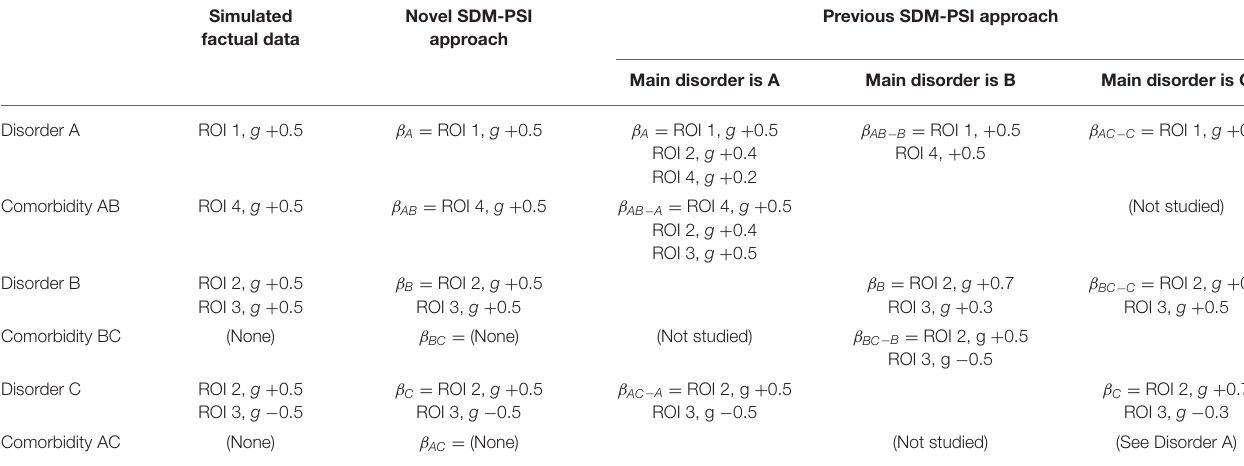
TABLE 1 | Results of the novel approach validation.